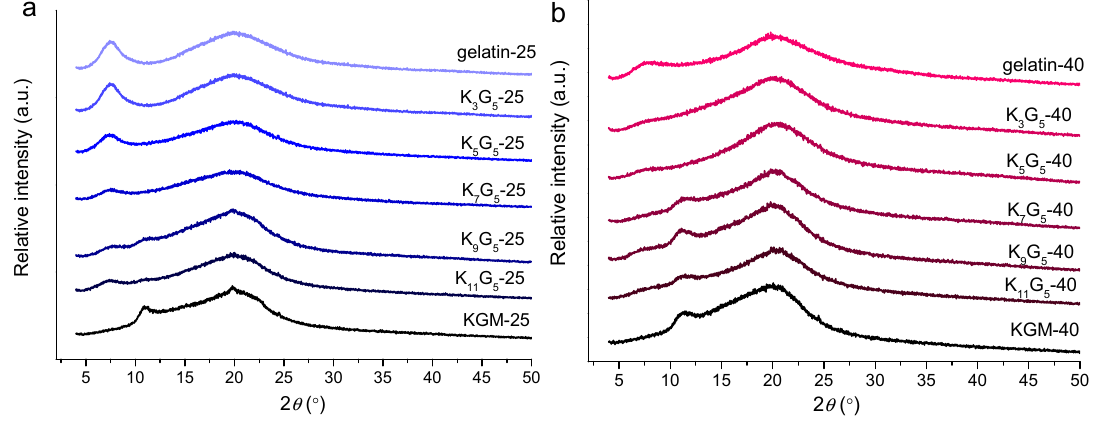
Figure 4. XRD patterns of KGM, gelatin, and KGM / gelatin films formed at drying temperatures of 25 ( a ) or 40 °C ( b ).